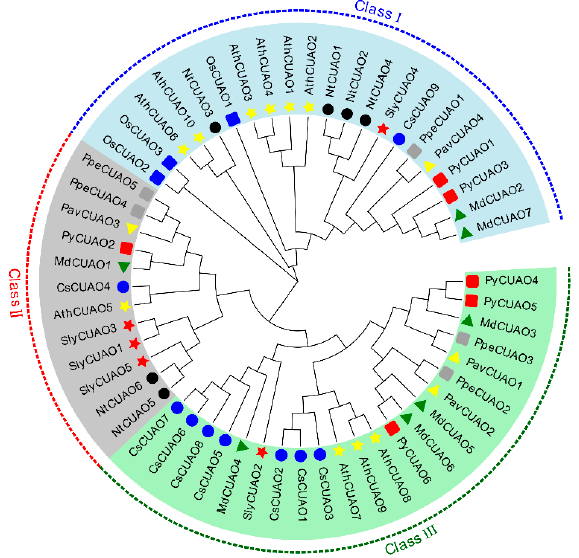
Figure 4. Phylogenetic tree of CuAO proteins from sweet cherry (Pav), peach (Ppe), Arabidopsis (Ath), tobacco (Nt), apple (Md), tomato (Sly), pear (Py), citrus (Cs), and rice (Os).